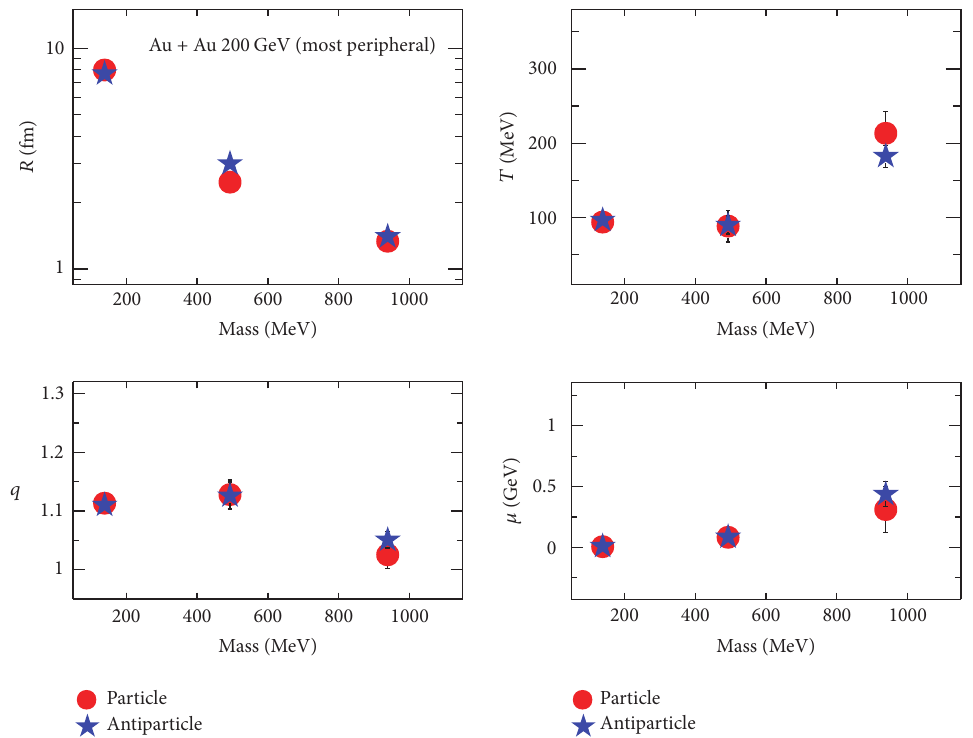
Figure 6: Mass dependence of extracted thermodynamic parameters using (6) for different particles and their corresponding antiparticles for most peripheral Au + Au collisions at √𝑠 NN = 200